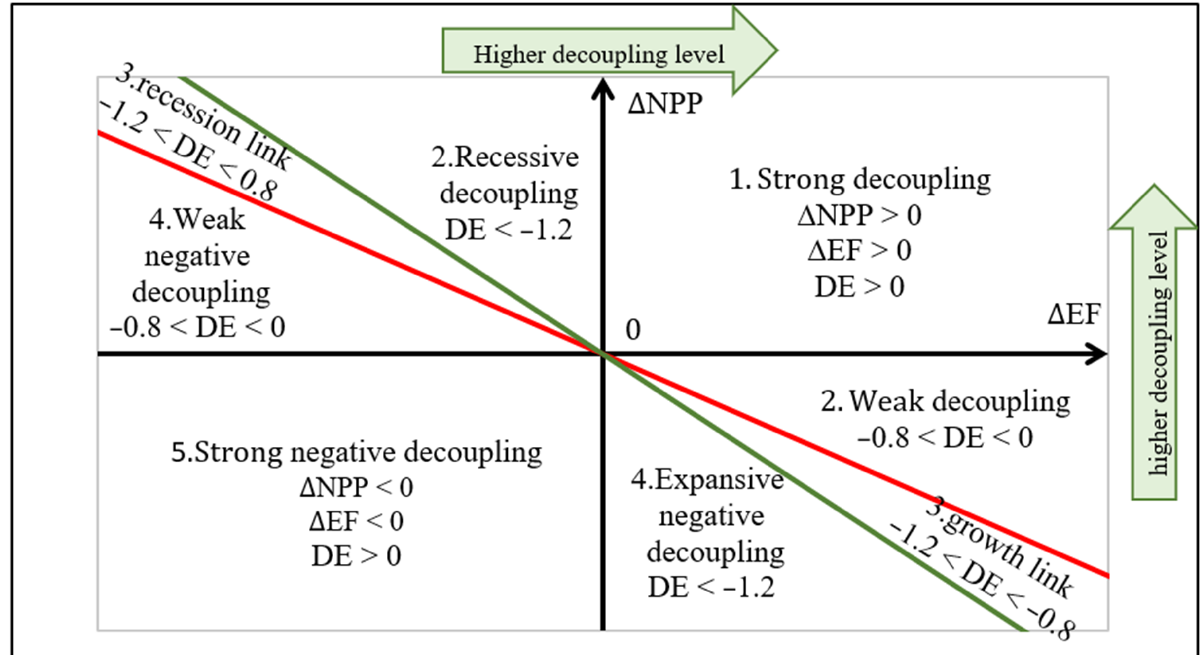
Figure 2. Division basis of the Tapio decoupling index model.